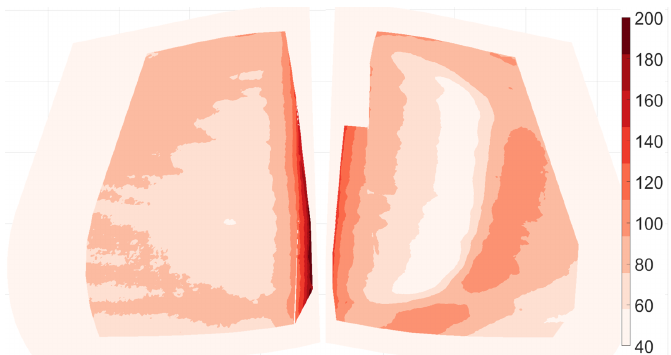
Figure 13. Contours of HTC on pressure ( left ) and suction side ( right ) for flow coefficient φ = 0.622.